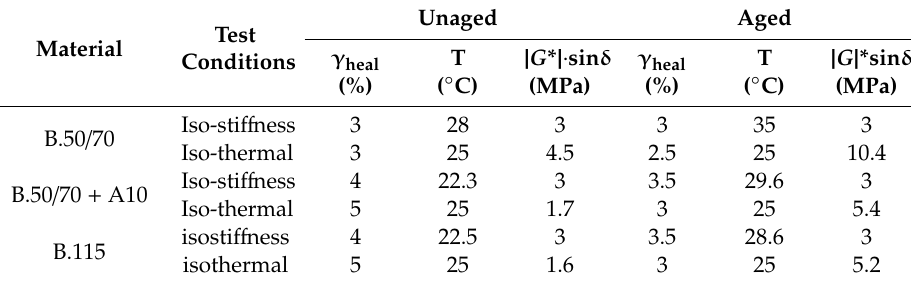
Table 4. Testing parameters for healing analysis.